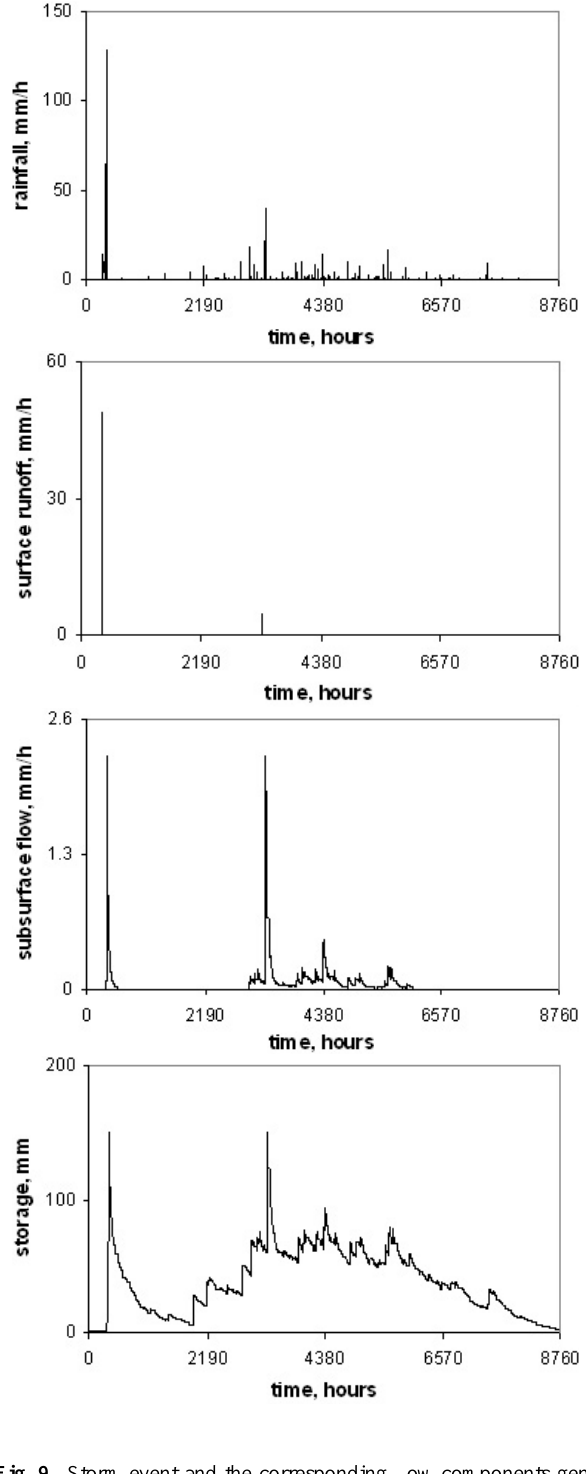
Fig. 9. Storm event and the corresponding flow components gen- erated by Model 4 using S b =150mm and η =0.5 in one year time window for (a) rainfall, (b) surface runoff, (c) subsurface flow, (d) catchment storage.